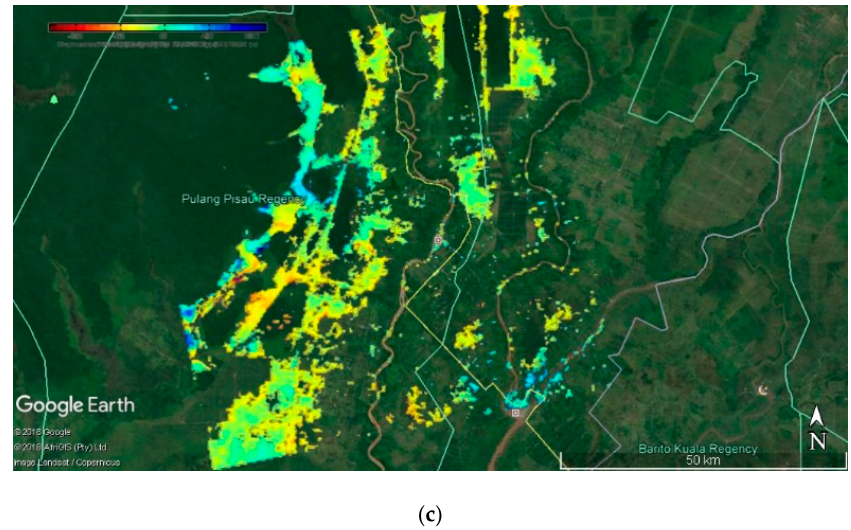
Figure 6. ( a ) Coherence image; ( b ) phase interferogram, and ( c ) land displacement map of this research area based on Synthetic Aperture Radar (SAR) interferometry processing ALOS-2 PALSAR-2 Data.